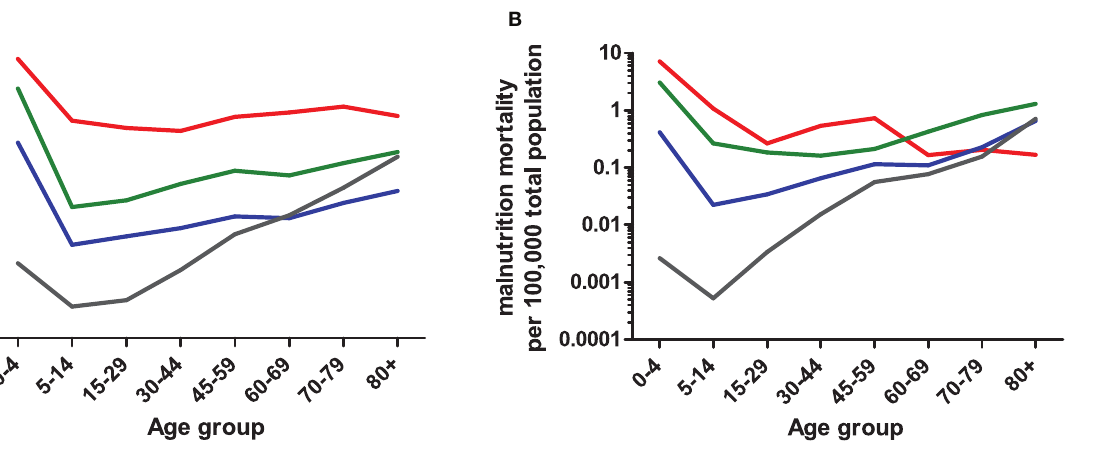
FIGURE 2 | Age-dependent mortality rates due to diarrhea (A) or protein-energy malnutrition (B) based on 2008 WHO data. Numbers of diarrheal or malnutrition from the Global Burden of Disease in 2008 cases were compared to the total population sum of each WHO region (2012). WHO regions were grouped into four categories (i.e., low, low-middle, upper-middle, and upper) based on Gross National Income (GNI) brackets established by the World Bank (2012). The GNI income bracket most represented within a WHO region was used to combine data. For example, the Region of Americas (AMRB) consists of 26 countries, the majority of